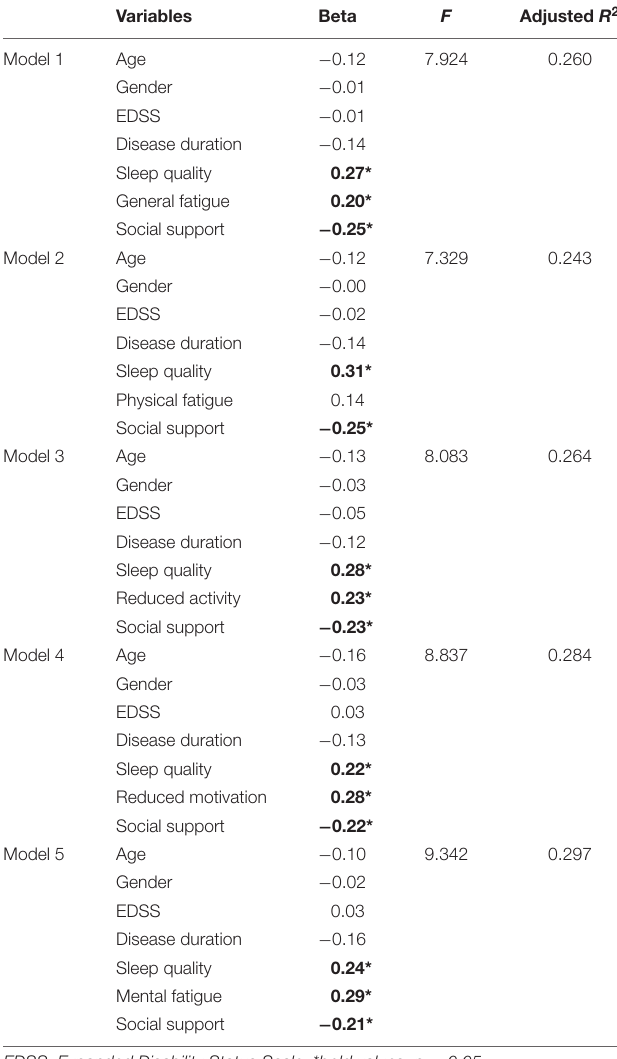
TABLE 3 | Linear regression analyses: Suicidal ideation regressed on demographic variables, EDSS, disease duration, sleep quality, social support, and five types of